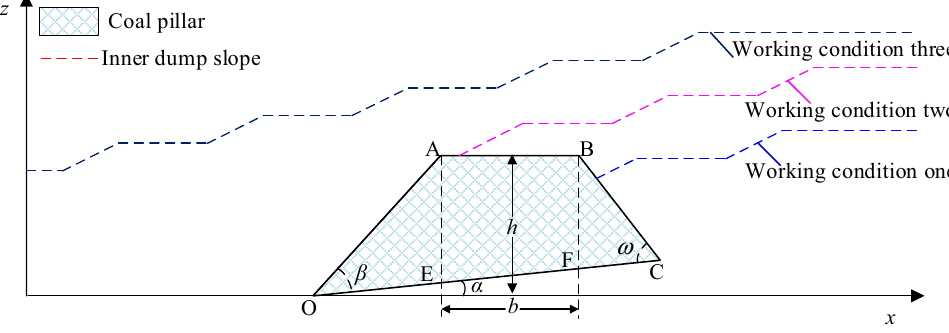
Fig. 5 Section indication under three working